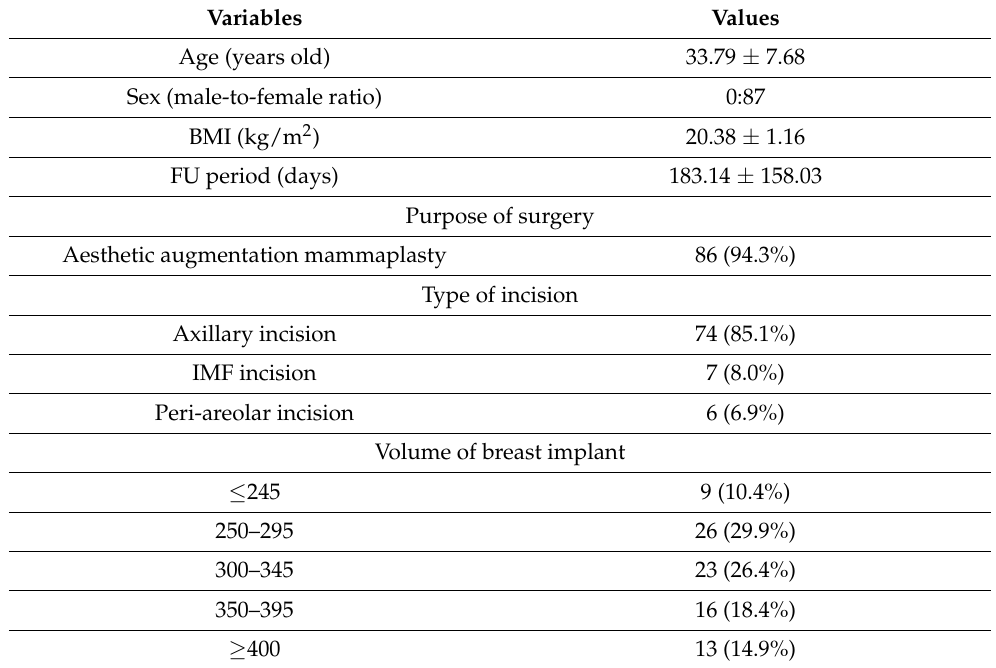
Table 1. Demographic and clinical characteristics of the patients ( n = 87).